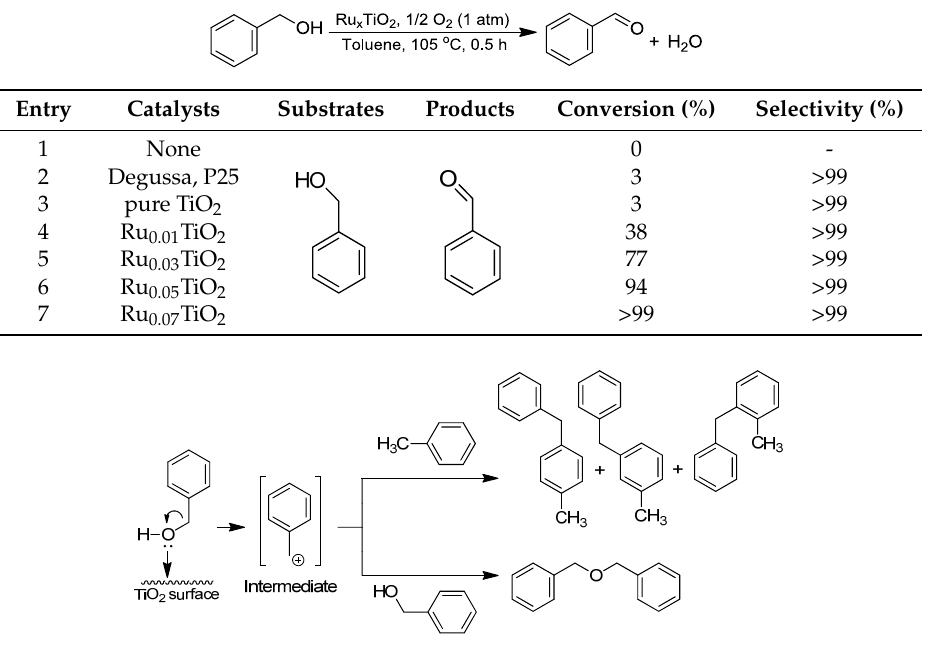
Scheme 1. Lewis acid (TiO 2 surface) catalyzed an electrophilic aromatic substitution and homo ‐